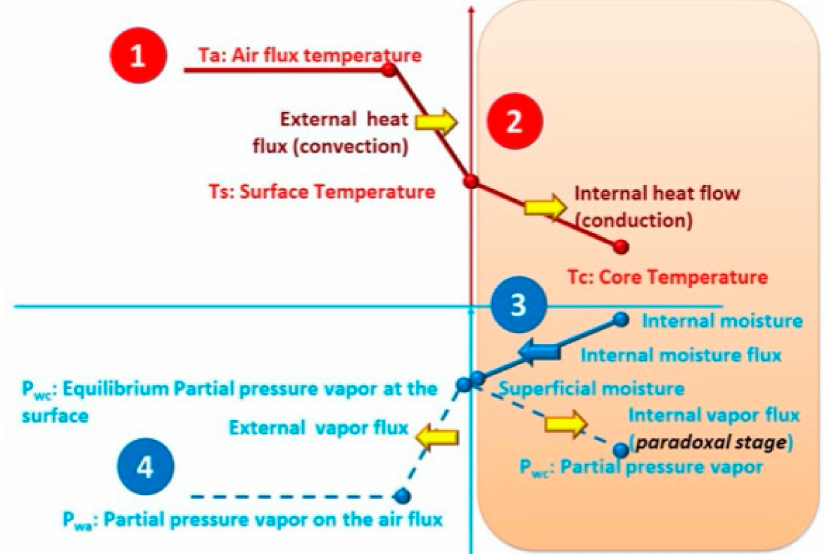
Figure 4. Scheme of the main transfer phenomena during convective airflow drying. (1) Heat transfer by convection; (2) Heat transfer by conduction within the food matrix; (3) Water transfer by diffusion and (4) Mass transfer by evaporation. Modified from Allaf et al.